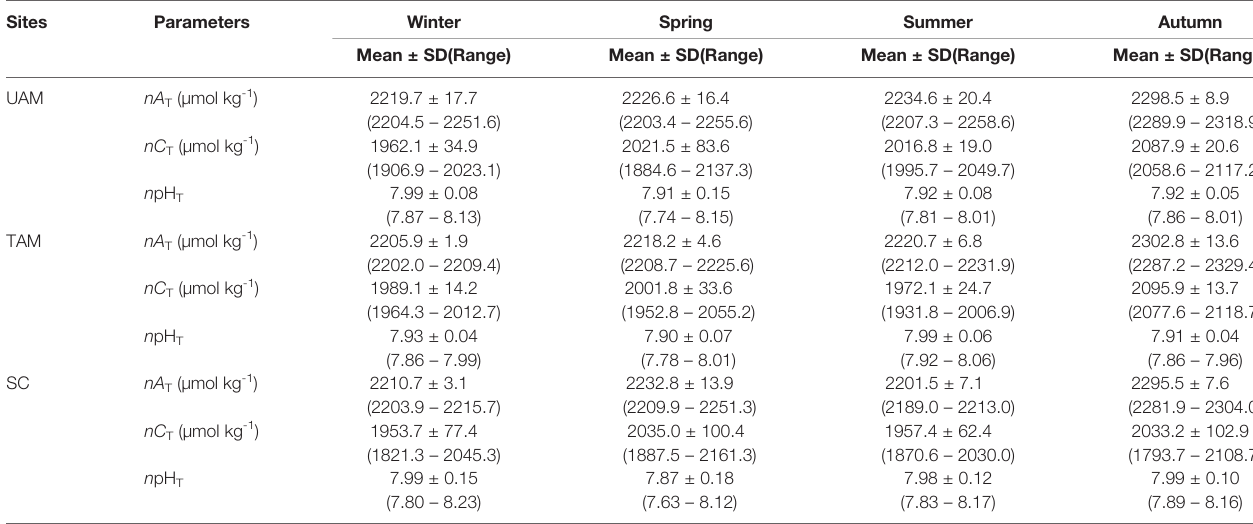
TABLE 1 | The mean ± standard deviation (SD) and variation range of seawater carbonate parameters (salinity normalized total alkalinity: nA T , salinity normalized total dissolved inorganic carbon: nC T , and temperature normalized pH total scale: n pH T ,) of three macroalgal habitats (UAM: ulvoid algal mat; TAM: turf algal mat; SC: coexisting Sargassum horneri and crustose coralline algae) in four